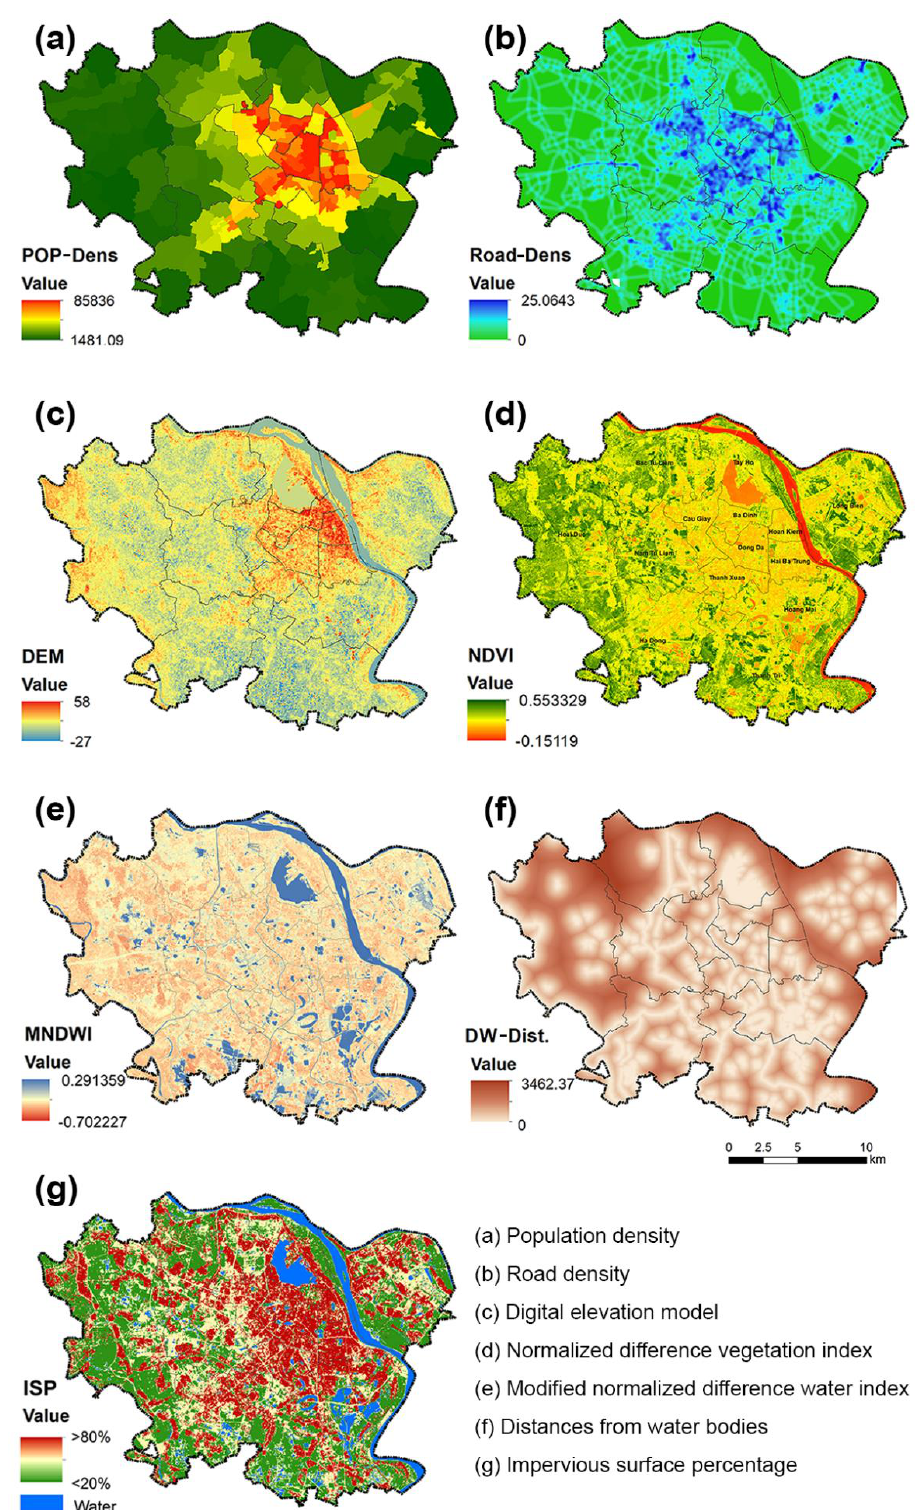
Figure 3. Spatial distribution of factors in the study area. Abbreviations: POP-Dens, population density; Road-Dens, road density; DEM, digital elevation model; NDVI, normalized difference vegetation index; MNDWI, modified normalized difference water index; DW-Dist, distances from water bodies; ISP, impervious surface percentage.